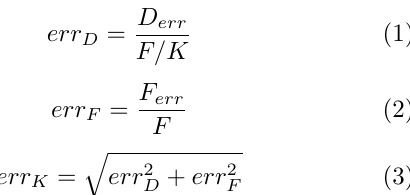
Figure 3: LVDT residue error after nonlinearity com-